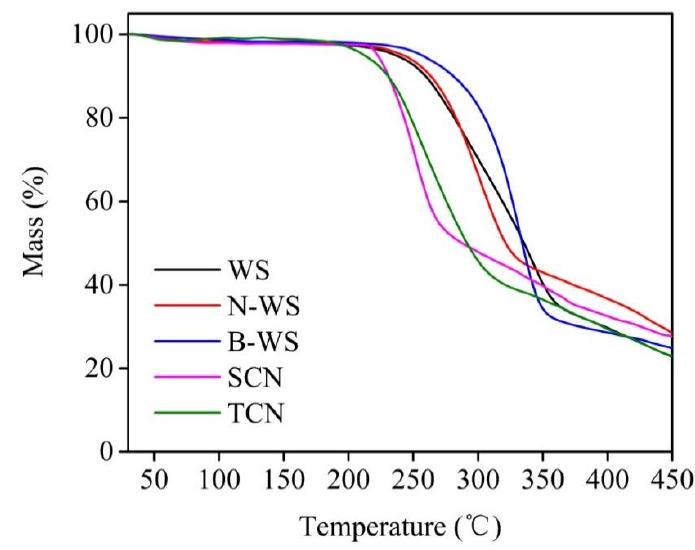
Figure 6. TGA curves of WS, N-WS, B-WS, TNC, and SNC.